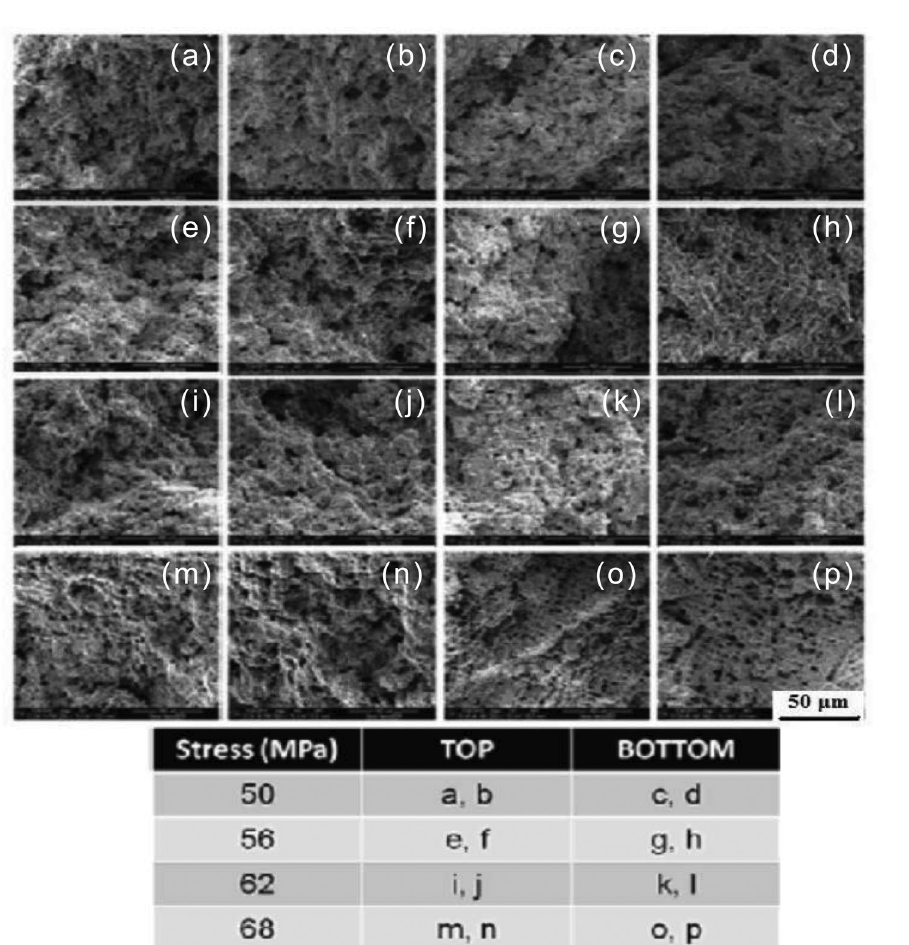
Figure 4: Fractograph of crept service exposed specimens (both top and bottom portion of the tube) tested at 870°C in the stress range of 52 – 68